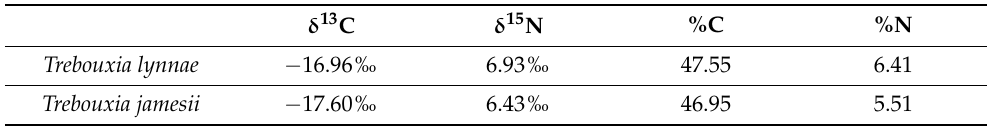
Table 2. The characterization of the isotopic composition of Trebouxia lynnae sp. nov. compared to T. jamesii . The isotopic composition is shown for carbon ( δ 13 C) and nitrogen ( δ 15 N), and the content of both elements is shown as ‰ of dry